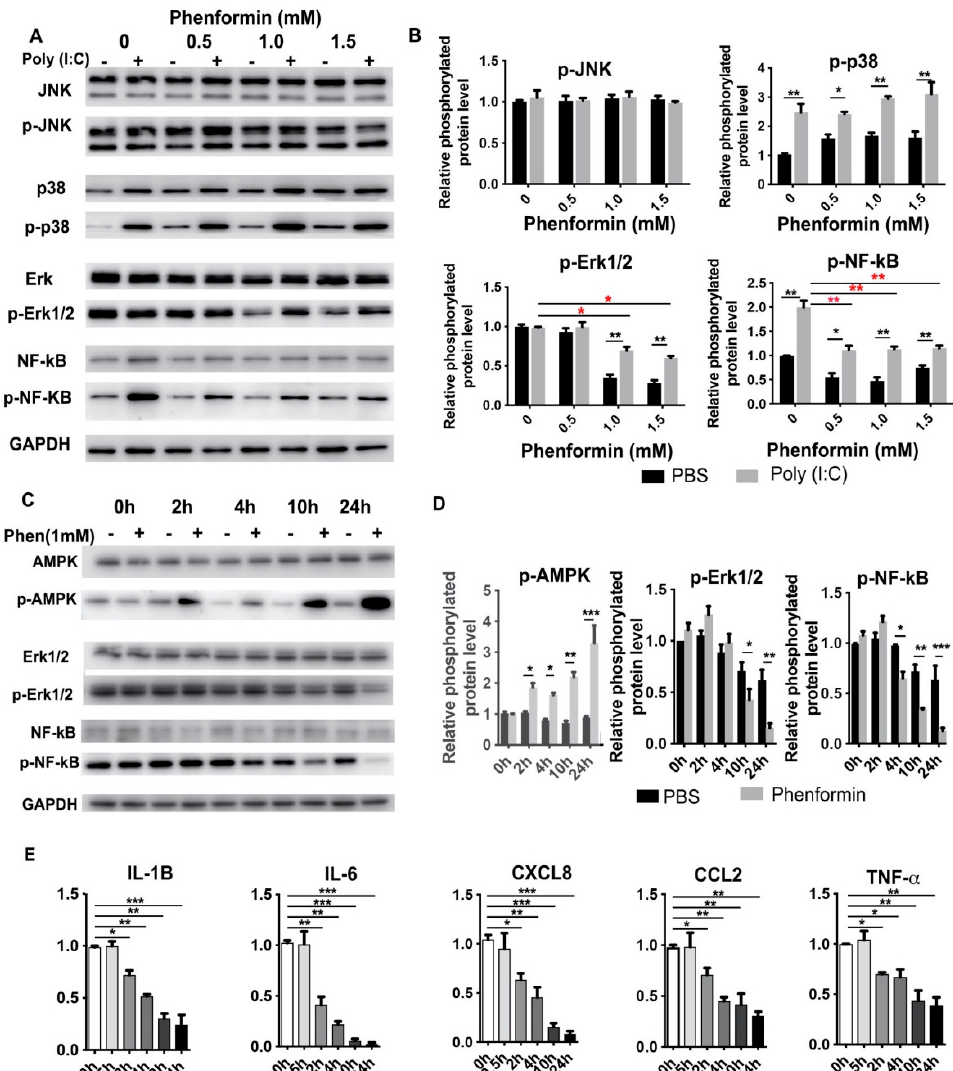
Figure 3. Phenformin suppresses the expression of pro-inflammatory cytokines in human ker- atinocytes but not directly through inhibition of the NF- κ B or MAPK signaling pathways at early time points. ( A , B ) Primary human keratinocytes were treated with 10 µ g/mL poly (I:C) with (+) or without ( − ) different concentrations (0, 0.5, 1.0 or 1.5 mM) of phenformin as indicated. At 24 h after treatment, cells were collected for Western blot analysis of total and phosphorylated levels of